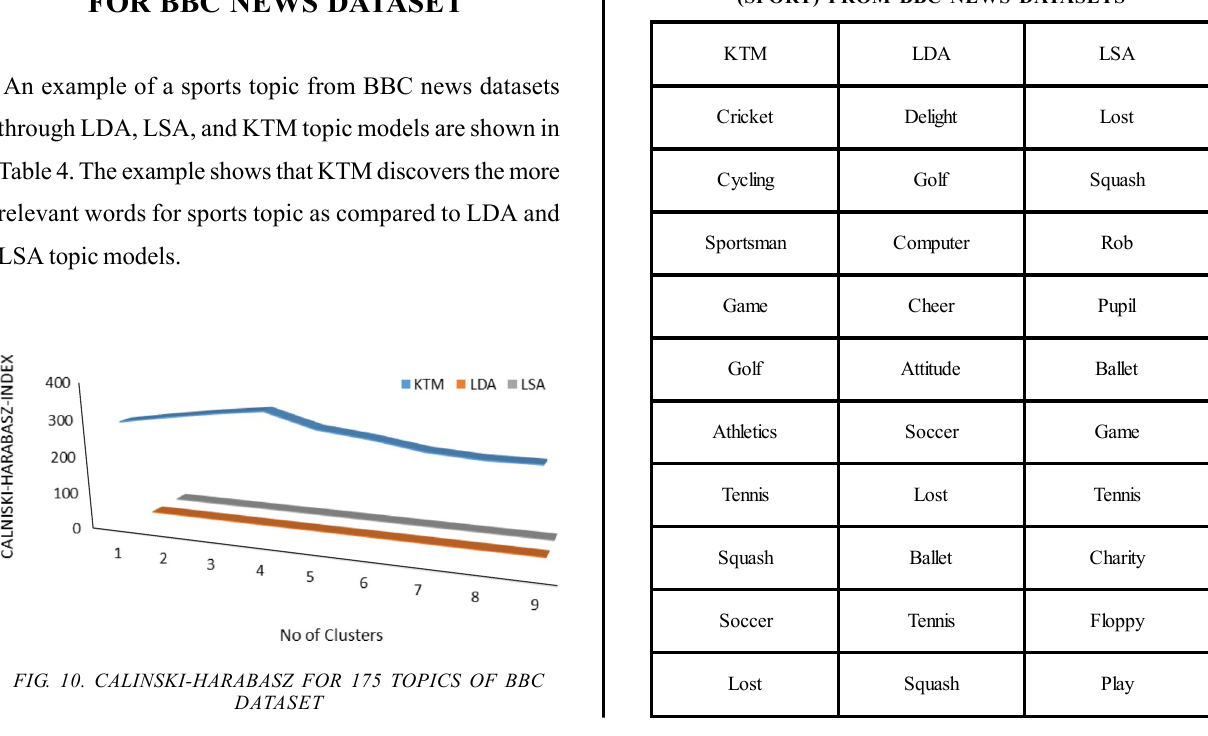
FIG. 12. KTM TIME EXECUTION OF CLUSTERING WITH A COMPARISON TO LDA AND LSA TABLE 4. EXAMPLE OF THE EXTRACTED TOPIC (SPORT) FROM BBC NEWS DATASETS